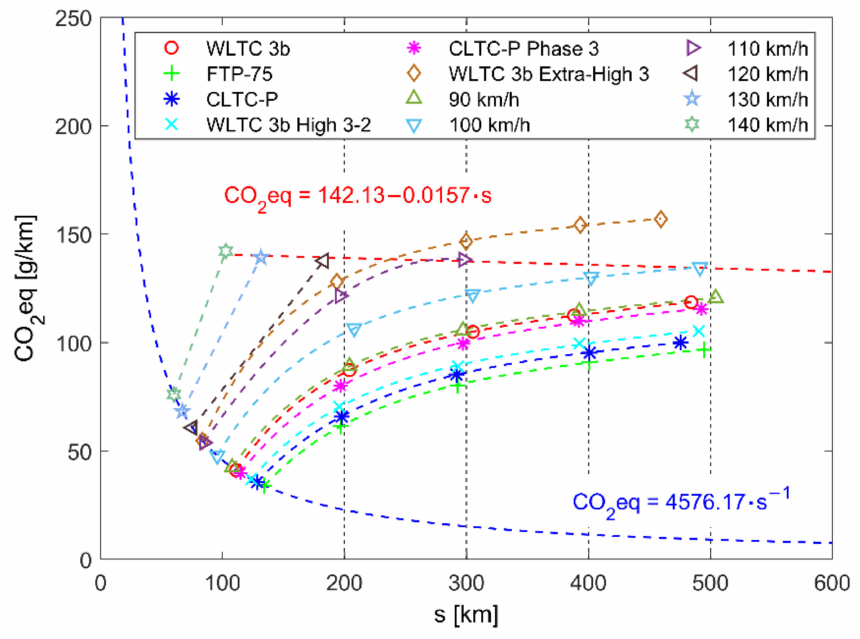
Figure A8. Combined CO 2 eq emission, due to EREV operation and electricity production (EU-27), in various driving conditions. Note that the blue approximation line (BEV mode) and the red approximation line (maximal range) are obtained for constant speed driving results from the range of 90–140 km/h. Vehicle mass is equal to 1800 kg.